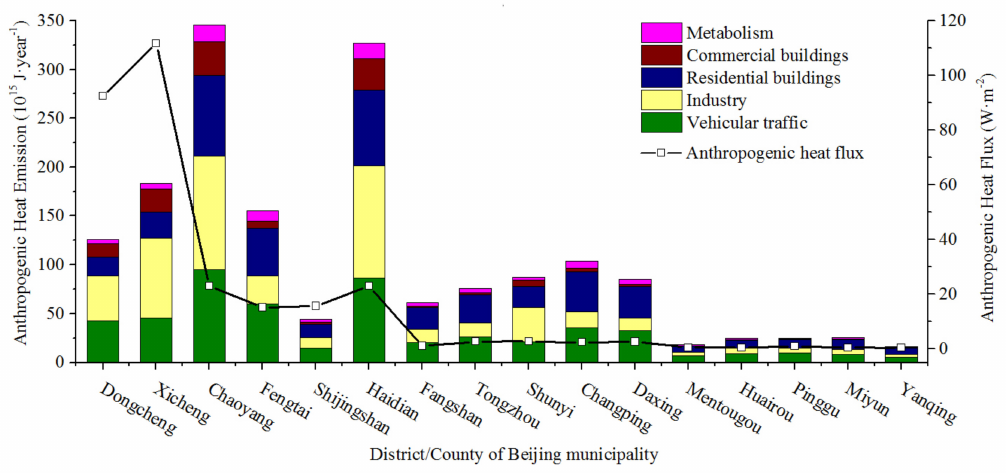
Figure 2. The annual total AH emissions and the annual mean AHF in the districts and counties of Beijing